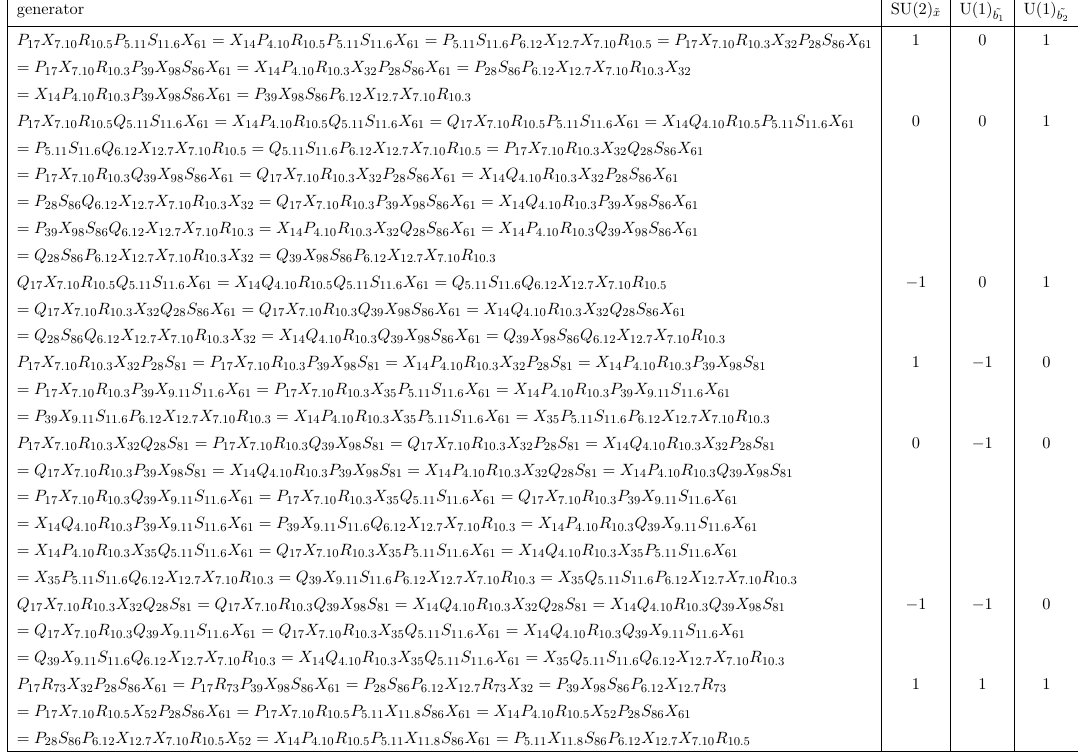
Table 69 . The generators in terms of bifundamental chiral fields for Model 17 (Part 1)